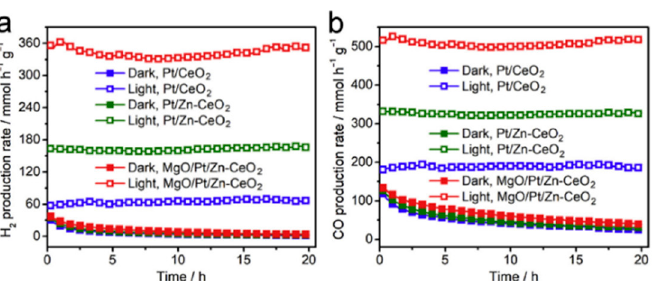
Figure 25. Stability test of DRM using the material described in Figure 23 and the references. The production rates of ( a ) H 2 and ( b ) CO. Copyright (2020), reprinted from [46] with permission from Elsevier.